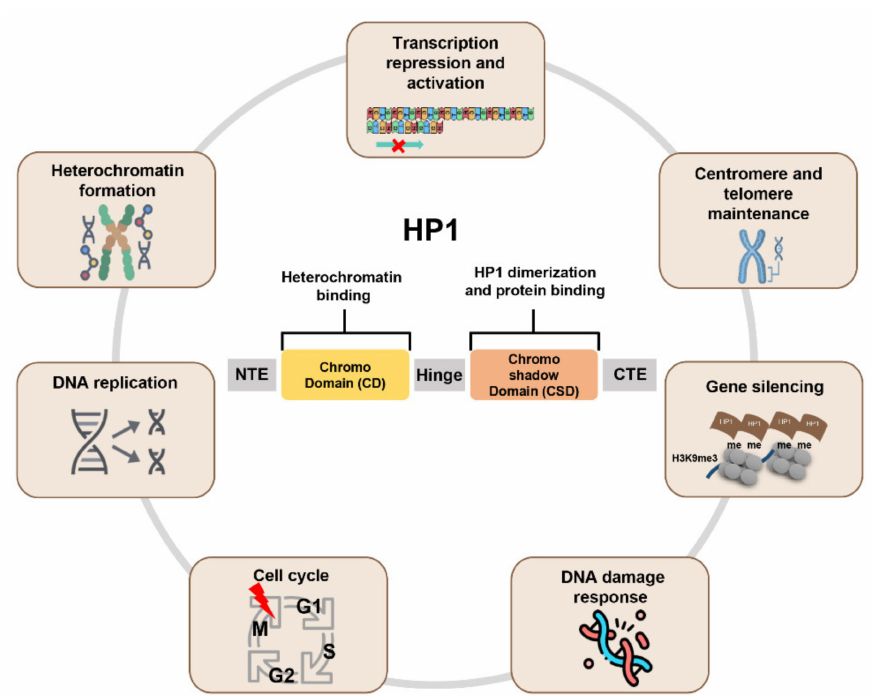
Figure 1. Schematic representation of HP1 function. All HP1 proteins have a chromodomain (CD) and chromoshadow domain (CSD). These domains are linked by the hinge. CD recognizes and interacts with the histone H3K9me3. CSD forms the HP1 dimer and interacts with other binding partners to perform various